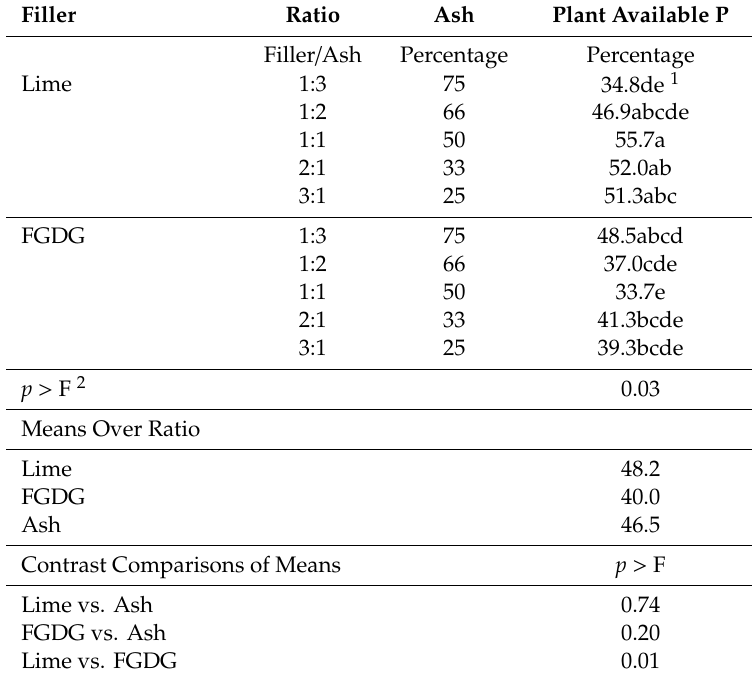
Table 3. Percentage of the P in ash that was plant-available as a ff ected by calcitic lime and flue gas desulfurization gypsum